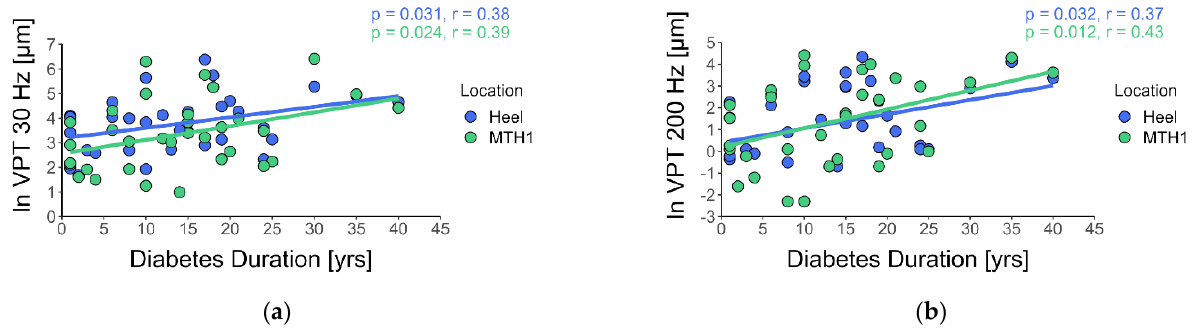
Figure 3. Pearson correlation between VPTs and DM duration. ( a ) correlation analysis between VPT at 30Hz and DM duration, ( b ) correlation analysis between VPT at 200Hz and DM duration.